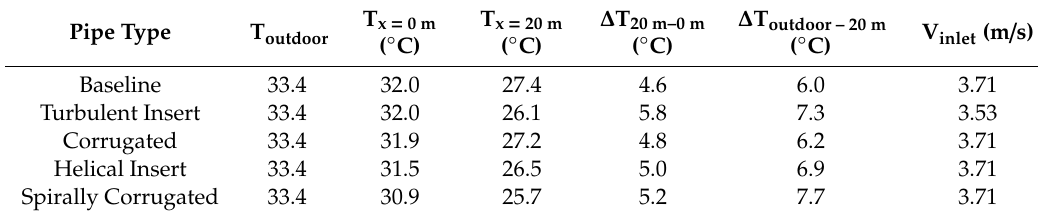
Table 6. Results for di ff erent pipe types using conditions from 13 August